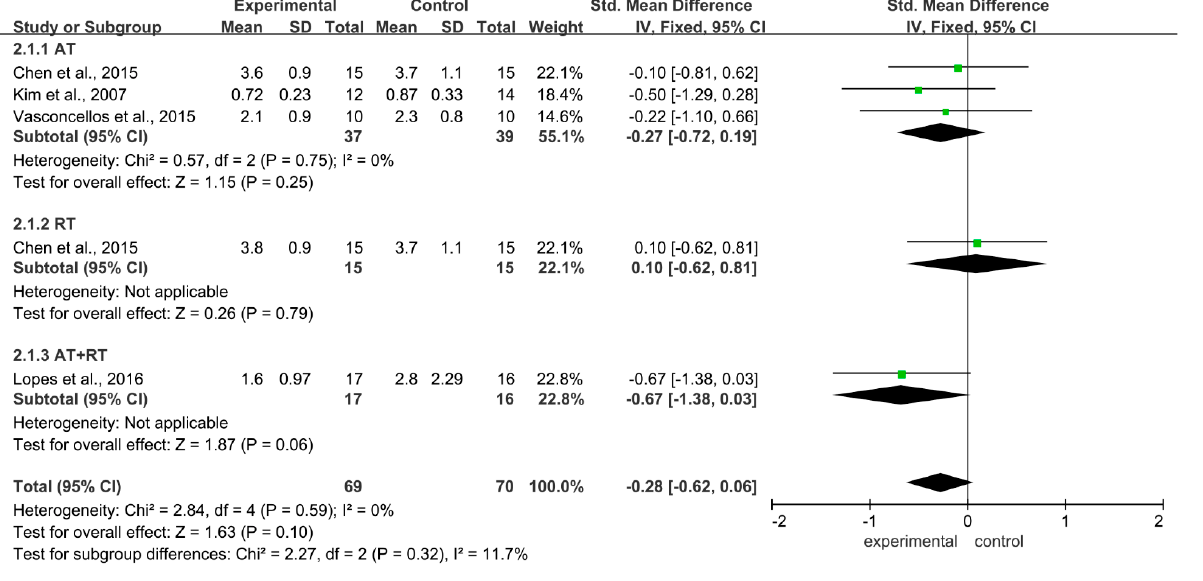
Figure 3. Meta-analysis of the effect of different training modalities on the level of IL-6 in adolescents with obesity.